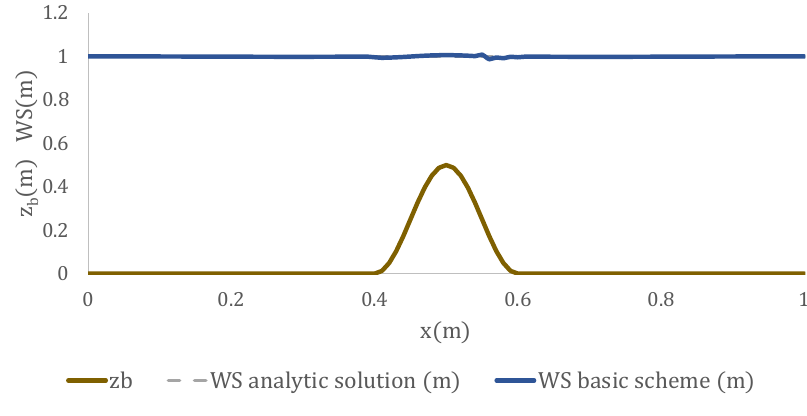
Figure 1. Basic-scheme: WS after 5000 time